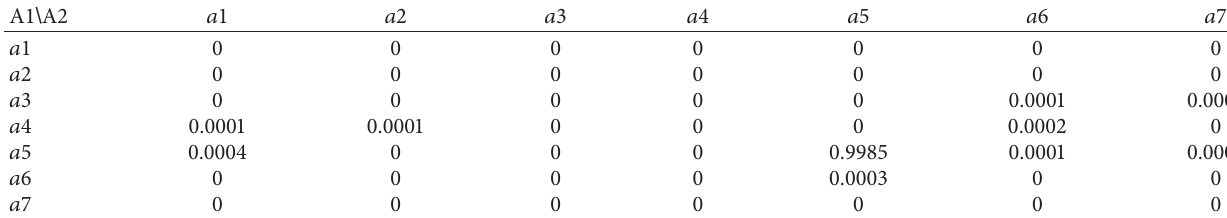
Table 4: Calculated optimal mix strategy of “A”: stage 2.